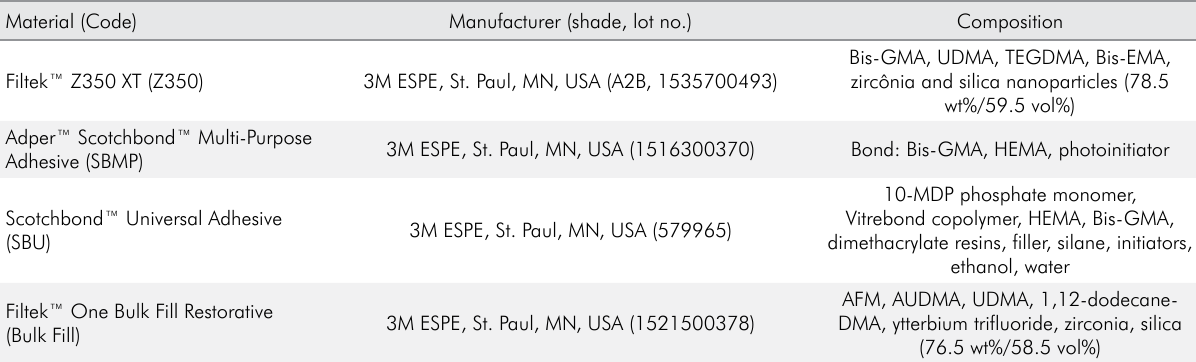
Table 1. Restorative materials used in the present study with their respective code, shade (if appropriate), lot number, and composition